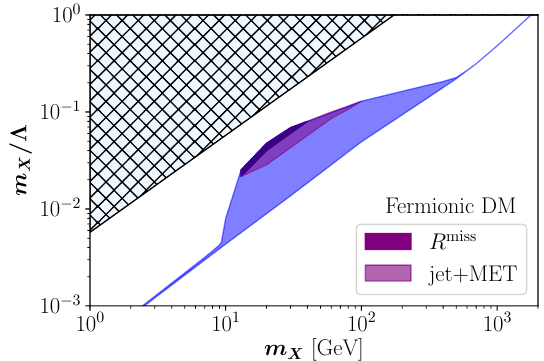
Figure 3 . Exclusion regions for the fermionic DM case obtained from the LHC recasting of the energetic jet + MET searches [18] (pink) and from R miss measurements [19] (purple), at p s = 13 TeV and integrated luminosity of 3.2 fb (cid:0) 1